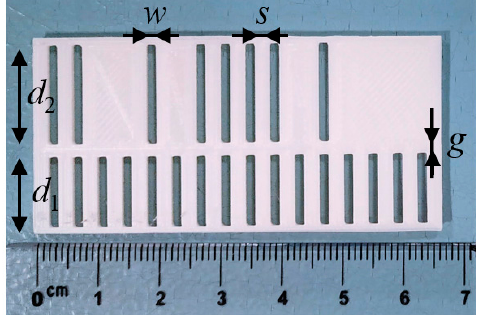
Figure 1. Photograph of the 3D-printed electromagnetic encoder. The total area of the encoder is 30 × 66 mm 2 , with the following aperture dimensions: d 1 = 11.5 mm; d 2 = 15.9 mm, w = 2 mm, s = 2 mm and g = 1.9 mm. The thickness of the encoder is 1.5 mm.